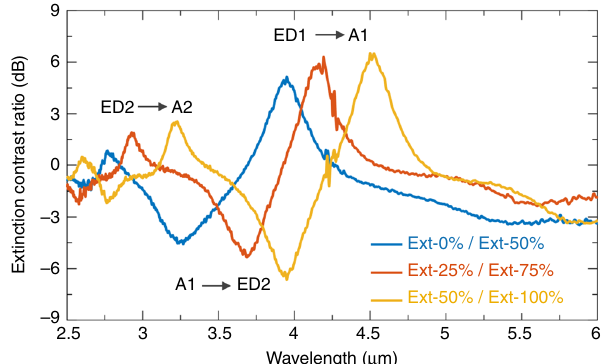
Fig. 5 Multispectral optical switch with multi-level control capabilities. Three representative extinction contrasts of GST disks ( R = 1 μ m, the same as in Fig. 3) with different crystallinities are plotted, which are between (i) C = 0% and C = 50% (blue), (ii) C = 25% and C = 75% (red), and (iii) C = 50% and C = 100% (yellow), respectively